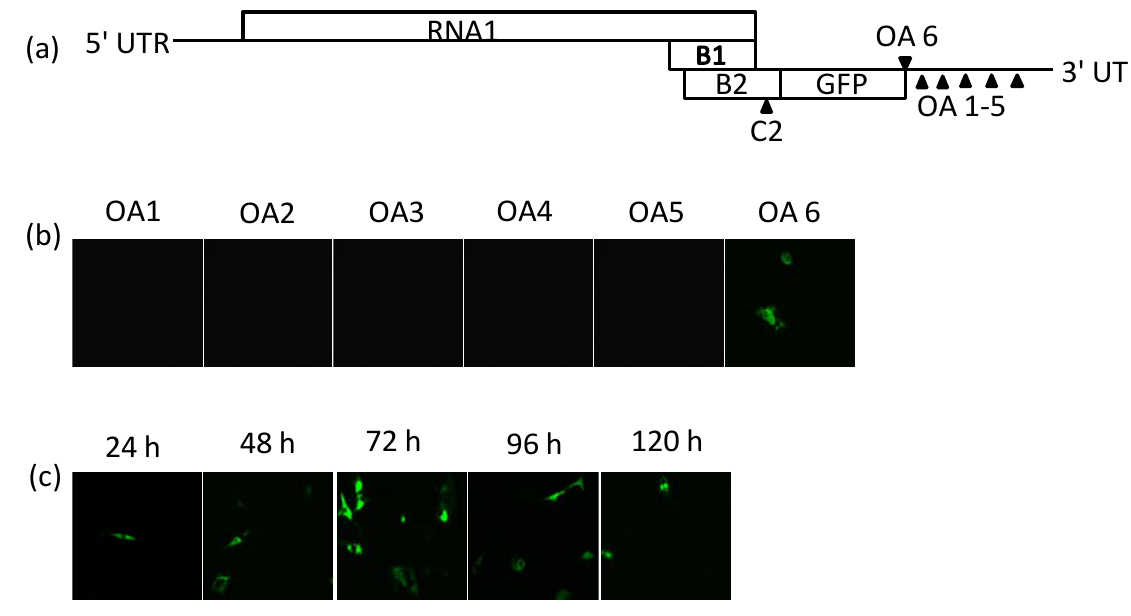
Figure 5. Construction and characterization of FHV-OA clones. ( a ) Schematic diagram showing the 6 OA insertion sites; ( b ) Fluorescence images of FHV-GFP-OA clones that were taken at 48 h after liposome-mediated transfection of BHK-21 cells; and ( c ) Time course assay showing GFP expression kinetics of FHV-C2-GFP-OA in BHK-21 cells after transfection with 2 µg of FHV-C2-GFP-OA RNA. All cell images are at 400×